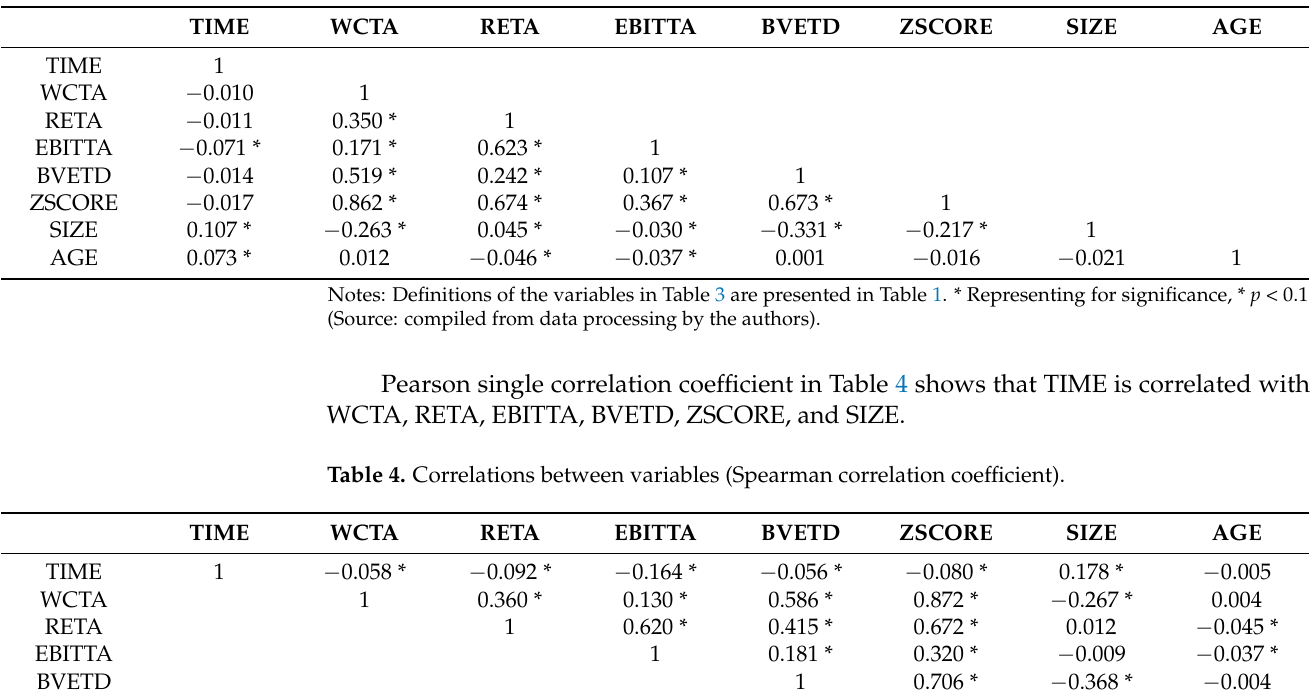
Table 3. Correlations between variables (Pearson correlation coefficient).